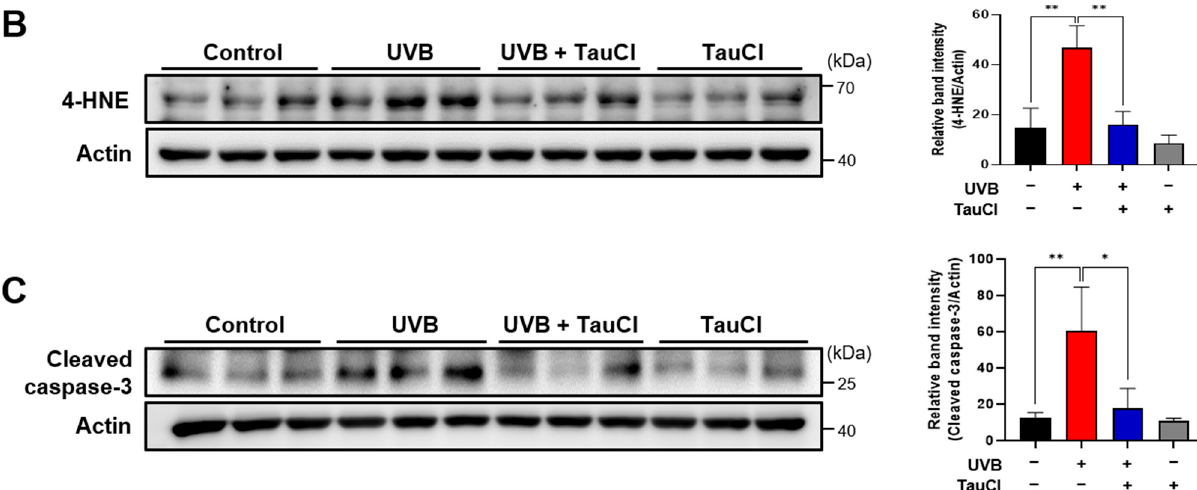
Figure 1. UVB-induced oxidative stress and apoptotic cell death were ameliorated in TauCl-treated mouse skin. ( A ) Skin thickness (double-headed arrow) and leukocyte infiltration (arrow head) were detected by H&E staining. Immunohisto- chemical analysis of 4-HNE-modified proteins (brown spots) and TUNEL-positive apoptotic cells in mouse epidermis. Magnification × 100. ( B ) The expression levels of 4-HNE-modified protein in UVB-irradiated mouse skin tissue with and without TauCl application were determined by Western blot analysis. Actin was used as an equal loading control. ( C ) Apoptosis was detected by measuring cleavage of caspase-3 by Western blot analysis. Data are analyzed by one-way ANOVA and expressed as means ± SD ( n = 3 per group). * , ** Significantly different between groups compared (* p < 0.05; ** p < 0.01).